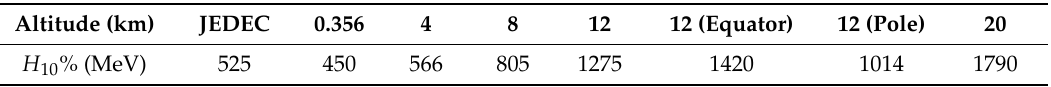
Table 1. Hardness factor at different altitudes over Geneva in km, compared to the NYC standard (JEDEC) and at varying latitude (0°, equator), (70°, pole). Altitude (km) JEDEC 0.356